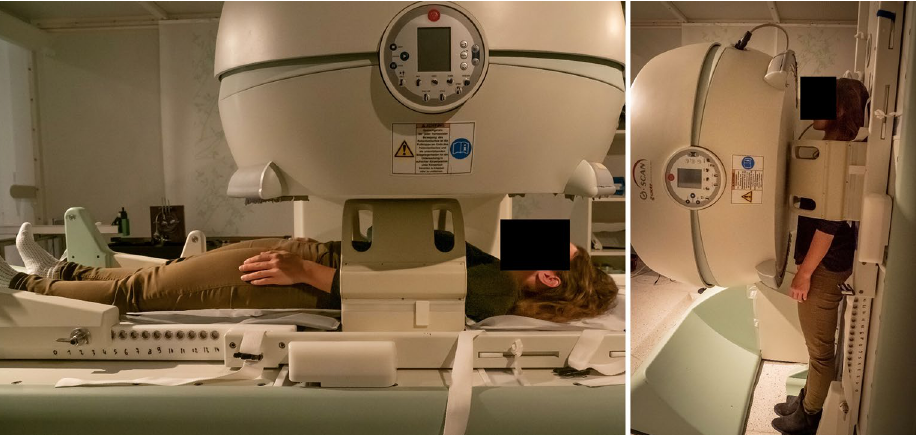
Figure 1. Subject positioning in the rotatable MRI system. Subjects were either placed in a lying supine (0°, left) or in an upright standing (80°, right)